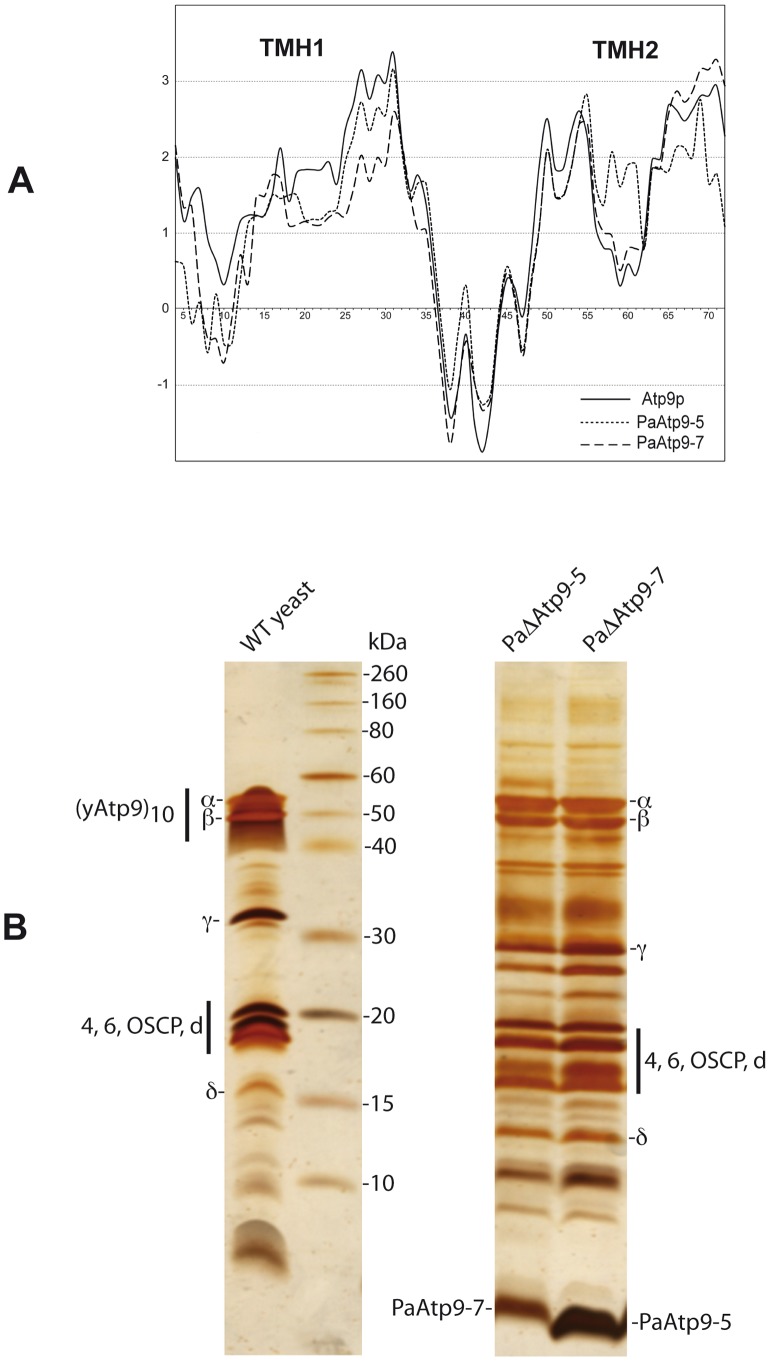
The P. anserina Atp9 proteins are less hydrophobic than yeast Atp9p.A) Hydropathy profiles of the PaAtp9-7 and PaAtp9-5 proteins and yeast Atp9p, generated according to [54] with a window size of 13. B) P. anserina strains expressing exclusively either PaAtp9-7 (PaΔAtp9-5) or PaAtp9-5 (PaΔAtp9-7) were constructed and ATP synthase was enriched from their mitochondrial extracts, separated by SDS-PAGE and silver-stained along with WT yeast ATP synthase. Positions of some ATP synthase subunits are indicated. The PaAtp9-5 protein is stained much more strongly than the PaAtp9-7 protein, which may be due to the differences in their amino acid sequences.